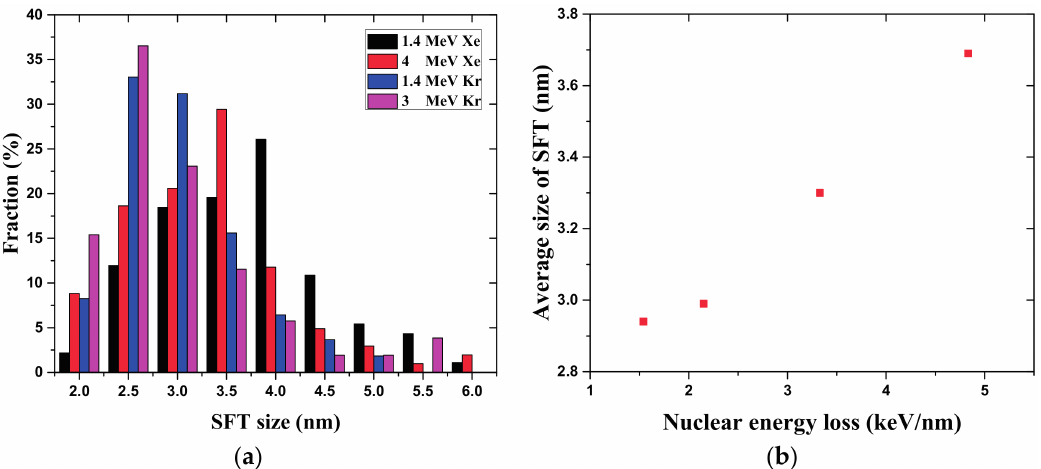
Figure 8. Size distribution of SFTs in gold nanowires. ( a ) The fraction of different SFT; ( b ) The relationship between average size of SFT and nuclear energy